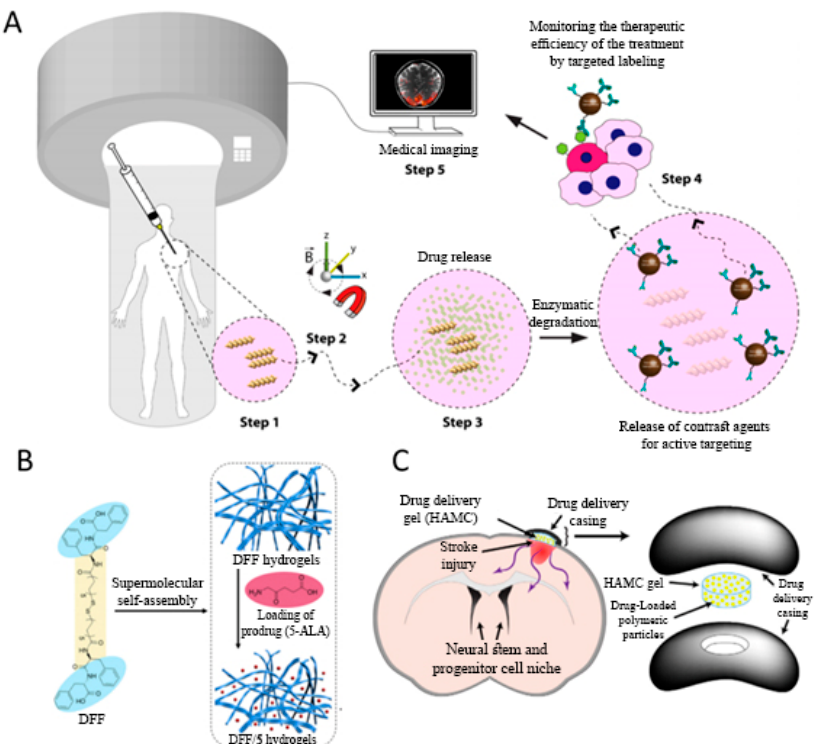
Figure 1. ( A ) Schematic view of the application of the 3D-printed micro-robotic swimmers. Micro-swimmers are directed to the disease or intervention site using an external magnetic force. Tumor microenvironment pathological condition led to the enzymatic degradation of the micro-swimmer by matrix metalloproteinase-2 (MMP-2), and boosted labeled-magnetic nanoparticle release. Antibody-modified magnetic contrast agents diffuse around to label the untreated tissue sites, Reprinted with permission from American chemical society. Adapted with permission from Ceylan et al. [33]. ( B ) Illustration of the composition of fibrous bola-dipeptide hydrogels for localized and sustained delivery of prodrug towards the tumor site. Adapted with permission from Zou et al. [45]. ( C ) Poly (lactic-co-glycolic acid) (PLGA) microparticle loaded hyaluronan/methylcellulose (HAMC) hydrogel for local drug release to the stroke injured brain tissue. The exact location of the hydrogel is held in place by both gelation and a casing comprised of polycarbonate discs. Adapted with permission from Tuladhar et al. [49].